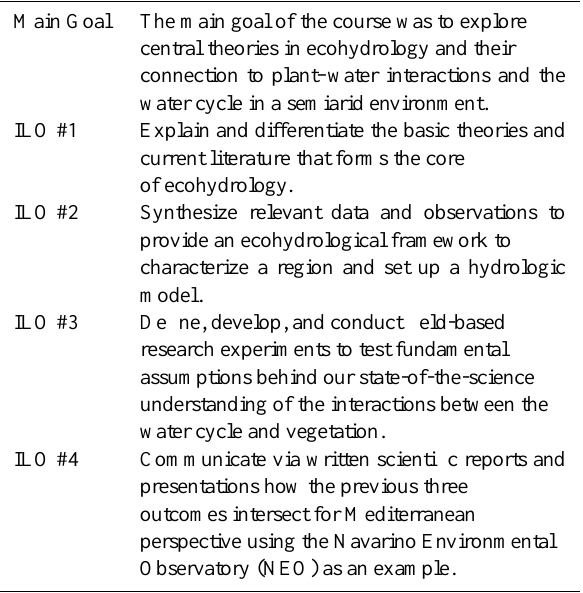
Table 1. The main goal and intended learning outcomes (ILOs)